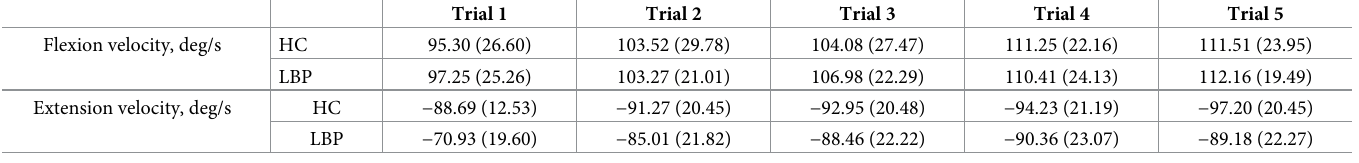
Table 2. The kinematic data for peak trunk flexion and peak trunk extension